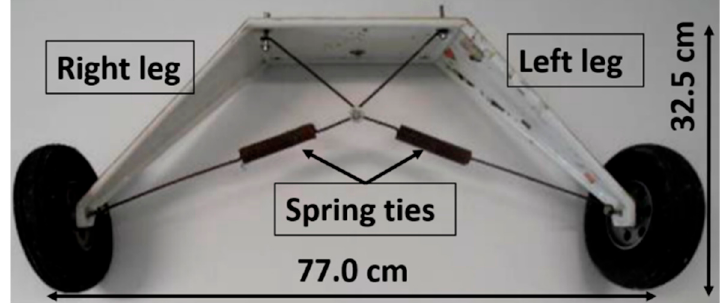
Figure 2. Test article’s overall dimensions.